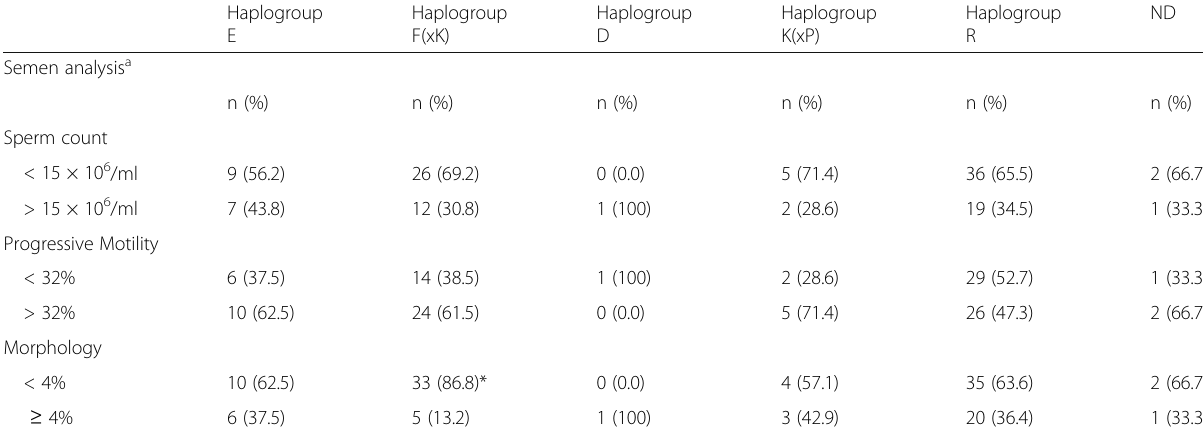
Table 3 Association analysis between Y chromosome haplogroups and sperm characteristics in infertile men